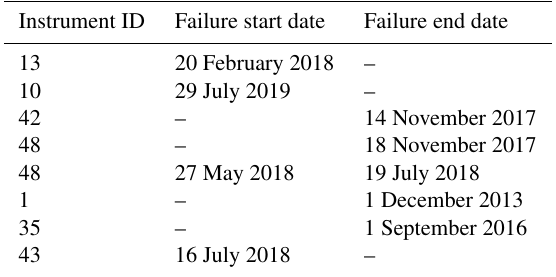
Table 4. Periods with suspicious recordings removed from the anal-